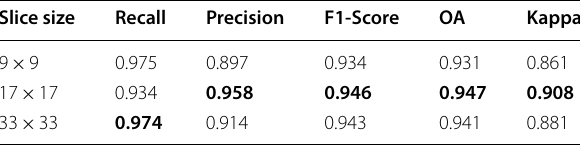
Table 1 Evaluation of the proposed model with the different slice sizes on dataset 1